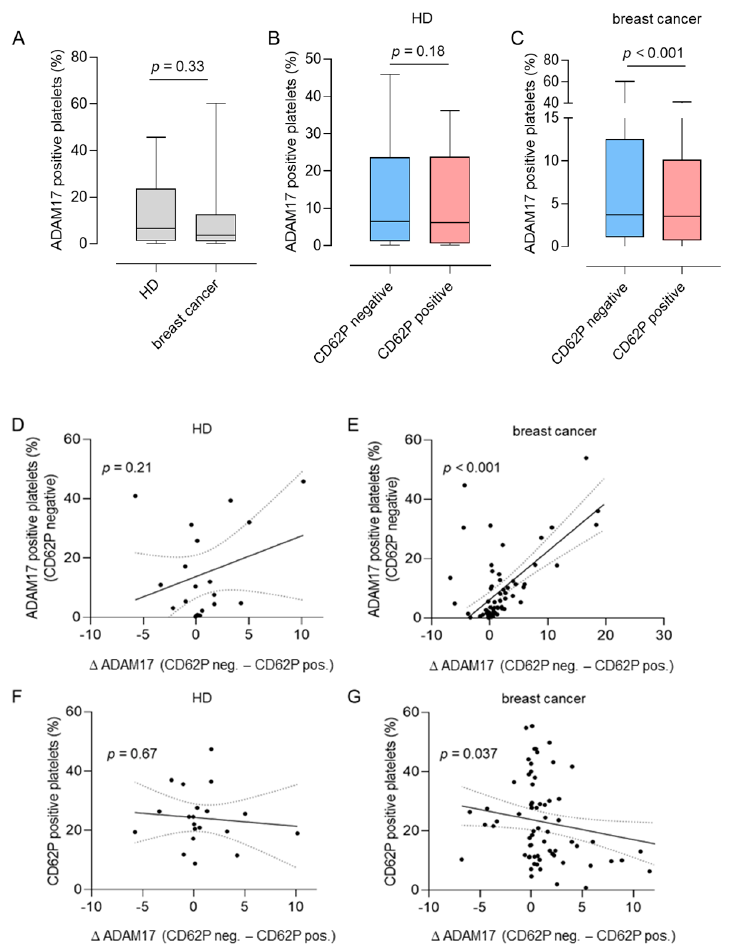
Figure 1. Platelet-derived A disintegrin and metalloproteinase 17 (pADAM17) upon platelet acti- vation. ( A ) ADAM17 surface levels in resting (CD62P negative) platelets from 20 healthy donors (HDs) and 79 breast cancer patients. ( B , C ) ADAM17 surface levels in resting (CD62P negative) and activated (CD62P positive) platelets ex vivo from HD ( B ) or breast cancer patients ( C ). The expression levels of ADAM17 on resting or activated platelets in a given donor are connected. ( D , E ) Regula- tion of pADAM17 ( ∆ pADAM17, defined as “the percentage of ADAM17 positive, CD62P negative platelets—the percentage of ADAM17 positive, CD62P positive platelets”) in HD ( D ) and breast cancer patients ( E) with regards to the basal pADAM17 expression levels (percentage of pADAM17 positive and CD62P negative platelets). ( F , G ) The extent of pADAM17 down-regulation upon platelet activation ( ∆ pADAM17) was analyzed in HD ( F ) and breast cancer patients ( G ) with regards to CD62P expression. Simple linear regression was used for statistical analysis in ( D – G